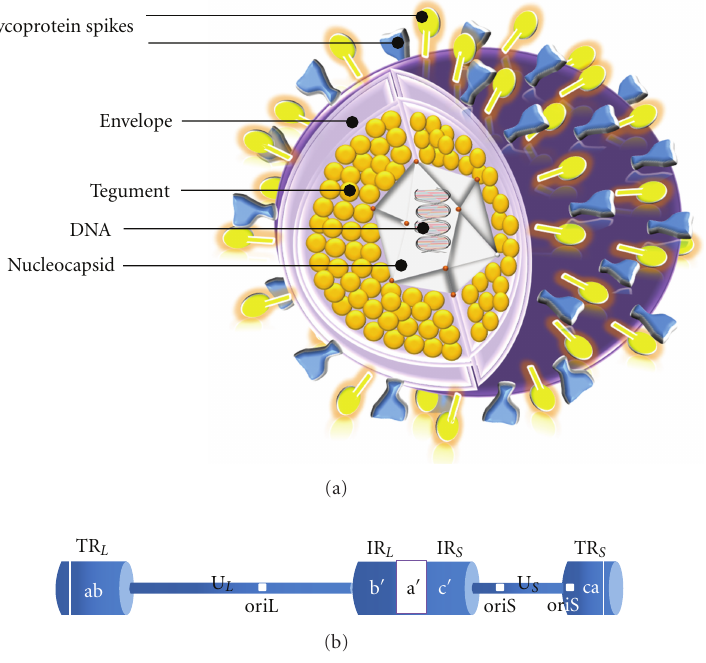
Figure 1: HSV-1 model structure and genome arrangement. (a) The icosahedral, DNA-containing capsid is asymmetrically located within the virion and surrounded by an amorphous protein layer called the tegument, and a membrane envelope heterogeneously studded with morphologically distinct spikes formed by 12 di ff erent glycoprotein species. (b) The HSV-1 genome arrangement showing repeats surrounding U L designated ab and b (cid:3) a (cid:3) , and those surrounding U S designated a (cid:3) c (cid:3) and ca. There are two di ff erent origins of replication, oriL in the long segment and oriS in the short segment. Abbreviations: U L : long unique sequence; U S : short unique sequence; TR L : terminal repeats of long segment; TR S : terminal repeats of short segment; IR L : internal repeat of the long segment; IR S : internal repeat of short